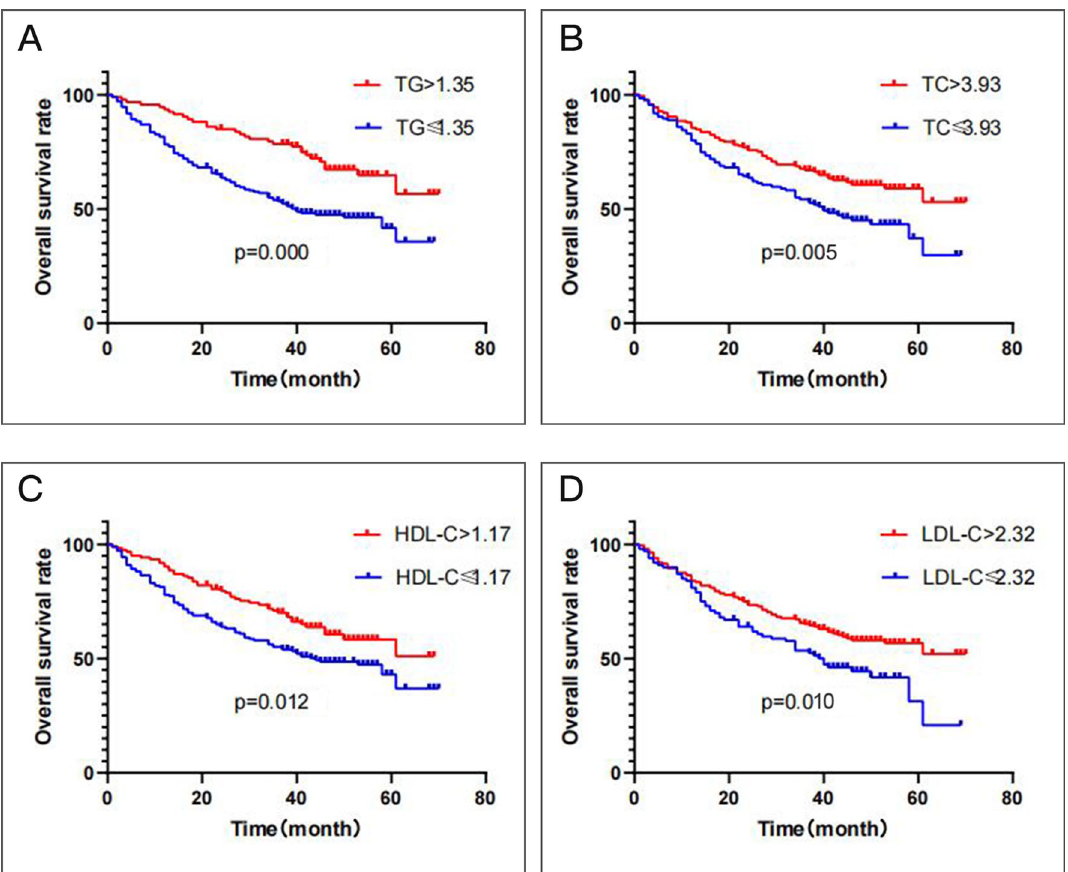
Figure 3. Kaplan–Meier curve for overall survival regarding low vs high TG levels (P = 0.000) ( A ); low vs high TC levels (P = 0.005) ( B ); low vs high HDL-C levels (P = 0.012) ( C ); low vs high LDL-C levels (P = 0.010) ( D